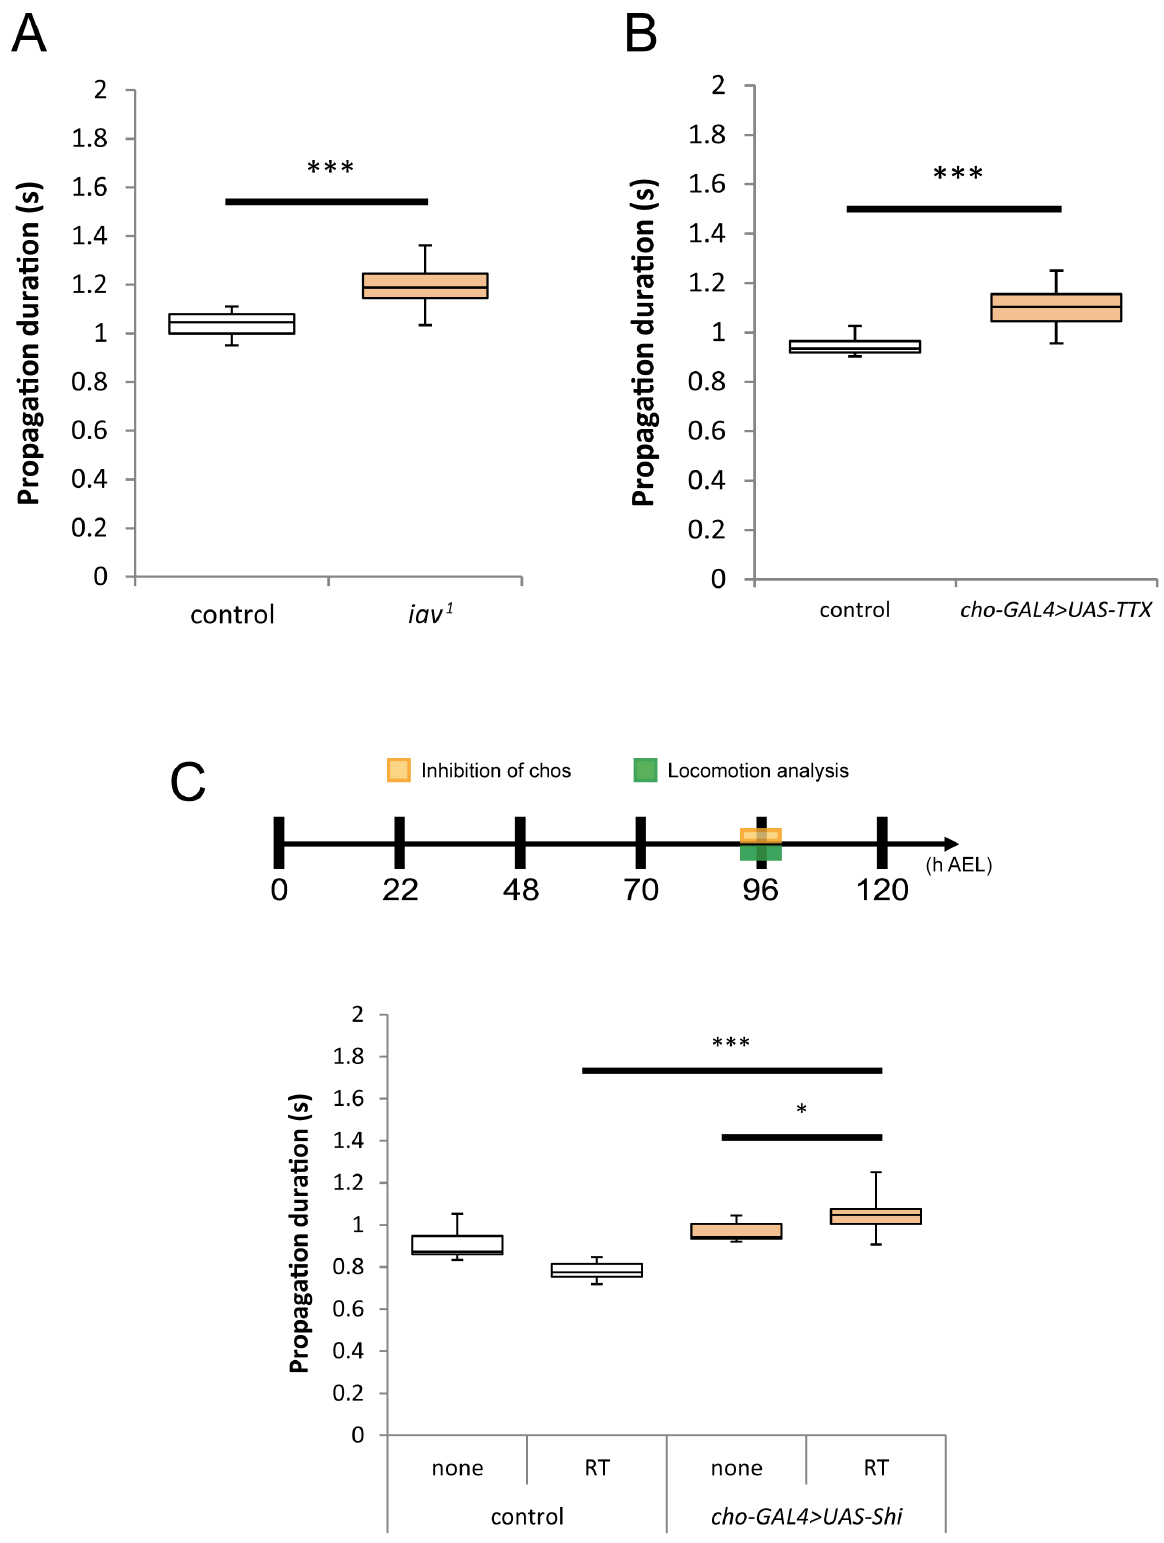
Figure 3. Chordotonal organs regulate locomotion through sensory feedback to the CNS. (A, B) Increase in propagation duration in iav 1 mutants (A) and in larvae expressing TeTxLc ( TTX ) in chos (B). (C) Acute inhibition of chos with Shibire ts increased the propagation duration of the larvae. Statistical analysis was done by Welch’s t test (***P , 0.001; *P , 0.05; n.s., not significant). For all conditions, n=10. RT, restrictive temperature. Controls were as follows: yw (A), yw . UAS-TTX (B), yw . UAS-Shi (C).